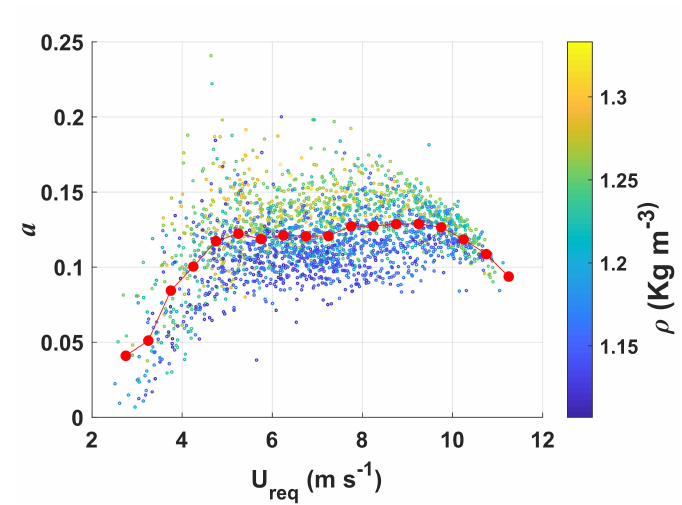
Figure 11. Variation of induction factor with wind speed and density, as derived from Equation (23), based on 10 min mean wind speed and turbulent flux data. An Induction curve is obtained using bins of 0.5 m s − 1 for U req